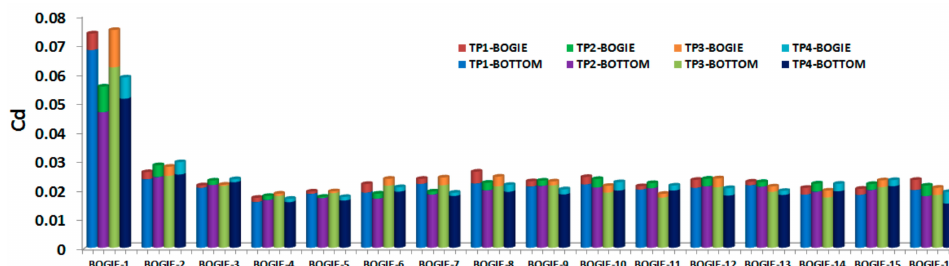
Figure 13. Time-averaged Cd of the bogie